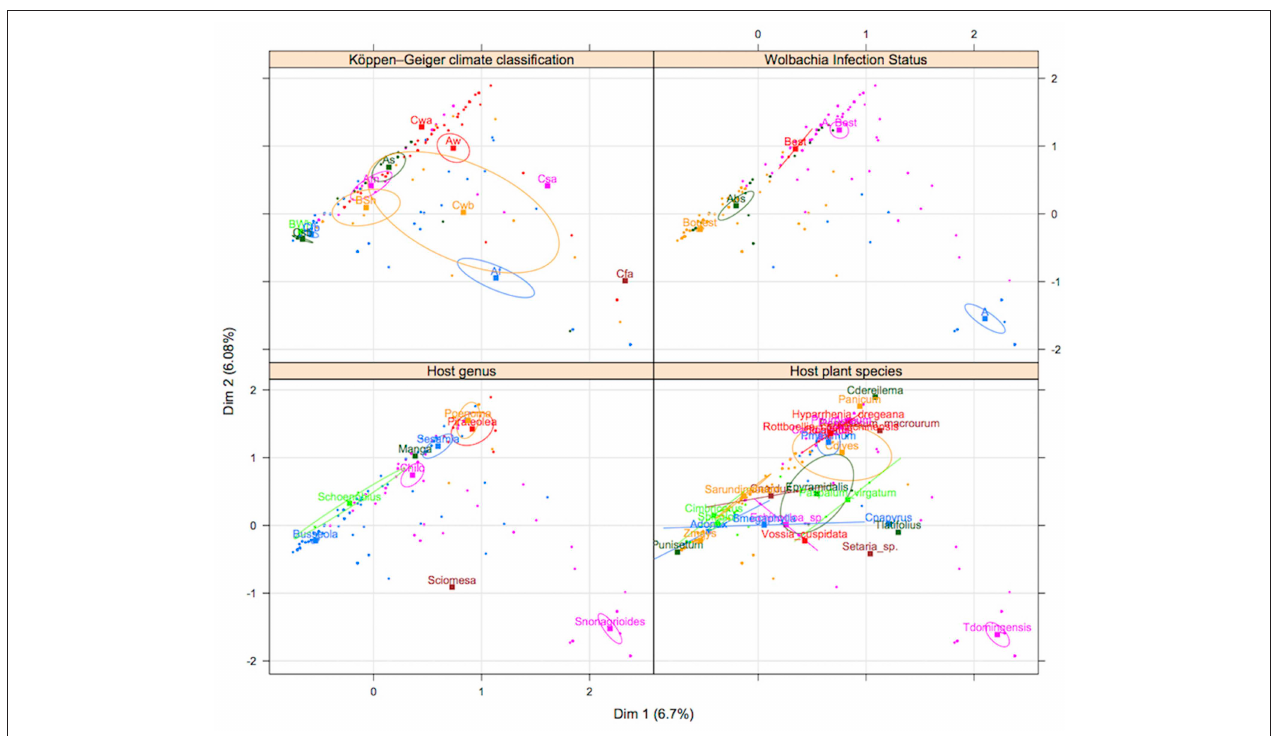
FIGURE 5 | Multiple correspondence analysis between ecological variables. Each point represents a data sample of Cotesia sesamiae . Each square represents the barycenter of each index in a categorical variable and the ellipse, the confidence at 0.95 of the barycenter